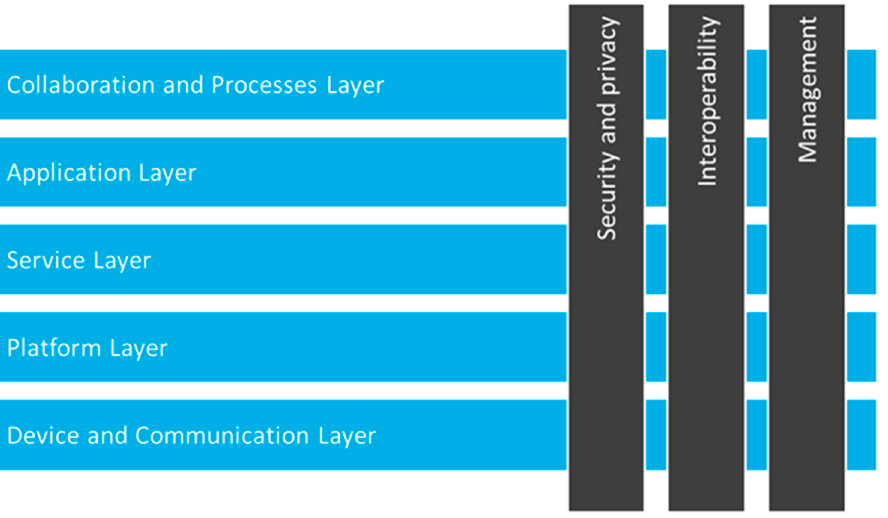
Figure 2. Pharaon’s high-level reference–logical architecture view.